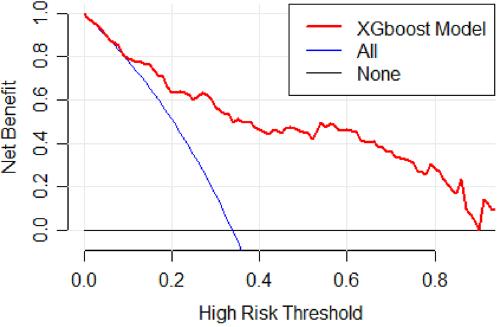
Figure 3. Decision curve depicting the net benefit obtained by using the regression model for different probability thresholds for recommending an intervention. The model demonstrates higher clinical net benefit compared to the default strategies across reasonable threshold